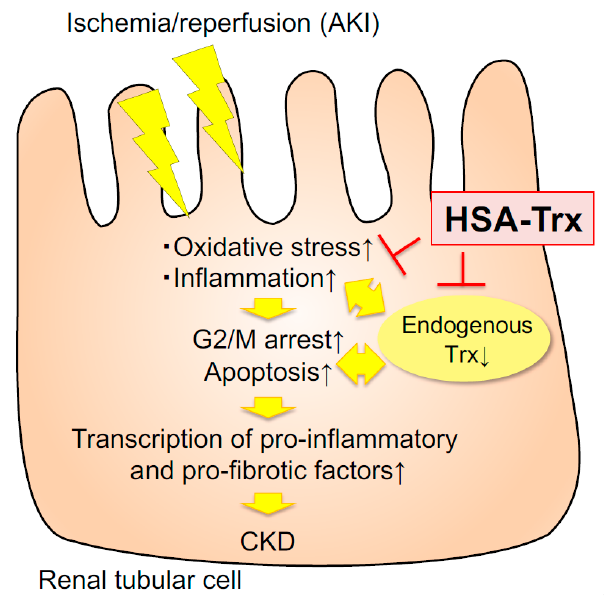
Figure 6. Schematic diagram of the effect of HSA-Trx on the AKI to CKD transition. AKI increased ( ↑ ) oxidative stress and inflammation, then decreased ( ↓ ) endogenous Trx.